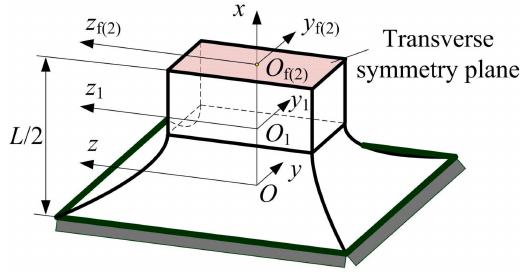
Figure 8. Geometric relationships among coordinate